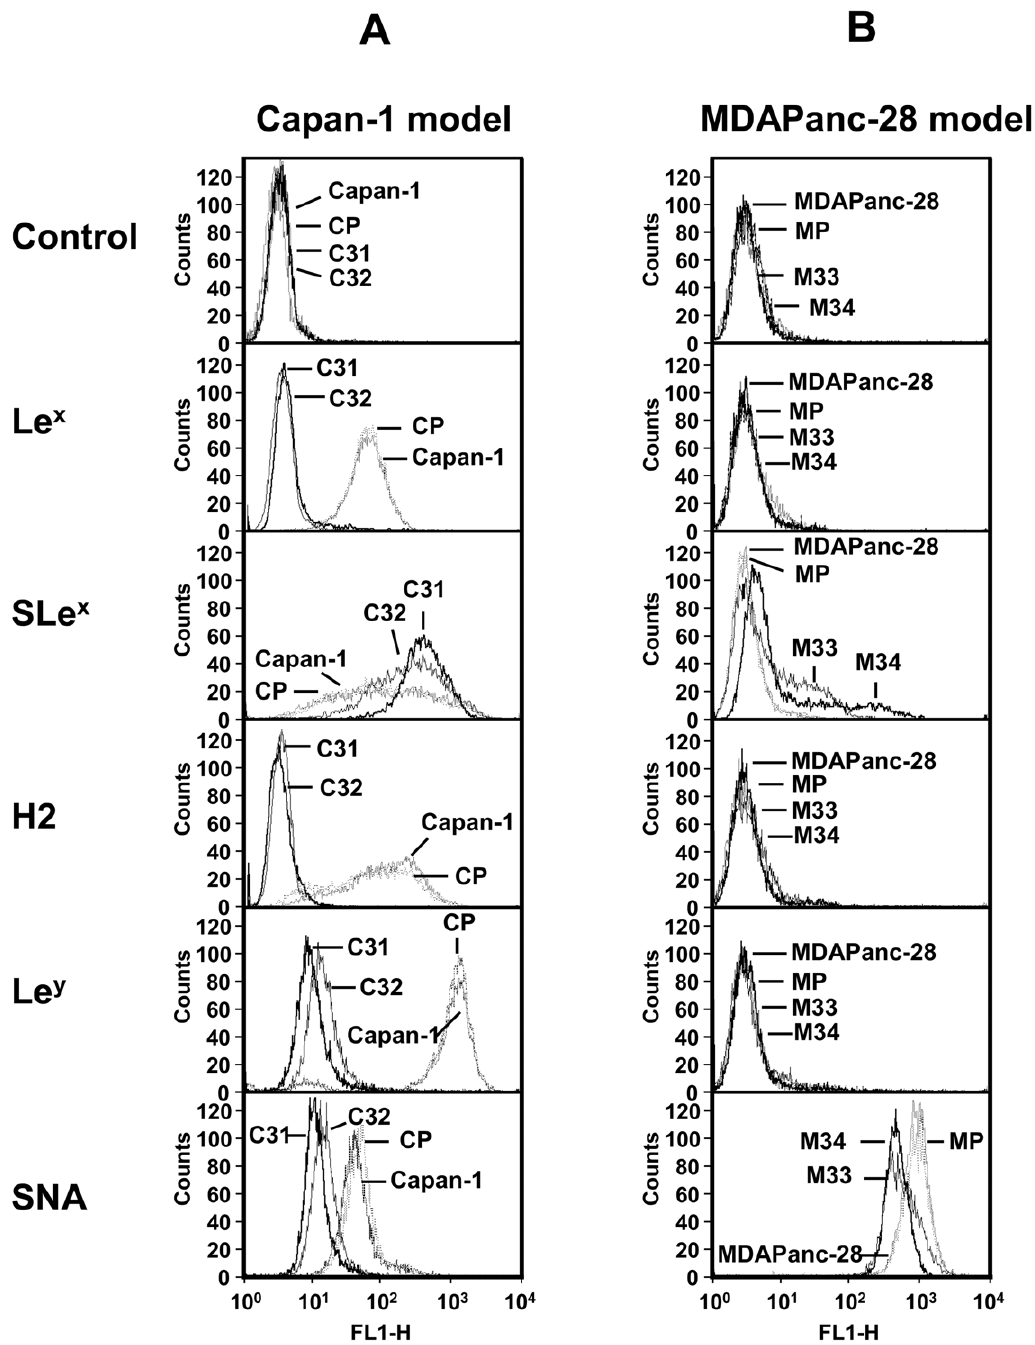
Figure 2. Flow cytometry profiles of the cell surface glycan structures of the pancreatic adenocarcionoma cells. Figure 2A . Capan-1 (continous dot outline: ………), CP (spaced dot outline: . . . . . ), C31 (bold outline:_______), C32 (plain outline:______). Figure 2B . MDAPanc-28 (continous dot outline: ………), MP (spaced dot outline: . . . . . ), M34 (bold outline:_______), M33 (plain outline:______). Experiments were performed for triplicate. Representative cytometry histograms are shown. Anti-Le x MAb binds to Gal b 1,4[Fuc a 1,3]GlcNAc-; anti-SLe x MAb binds to NeuAc a 2- 3Gal b 1,4[Fuc a 1,3]GlcNAc-; anti-H2 MAb binds to [Fuc a 1,2]Gal b 1,4GlcNAc-; anti-Le y MAb binds to [Fuc a 1,2]Gal b 1,4[Fuc a 1,3]GlcNAc-; SNA lectin ( Sambucus nigra agglutinin) binds to NeuAc a 2–6Gal b - structures. doi:10.1371/journal.pone.0012524.g002 H2 and Le y ). Moreover, accompanying the increase in SLe x , a antigens SLe a , Le a , Le b and H1 were not detected in the Capan-1 decrease in a 2,6-sialic acid was observed, detected by Sambucus model (data not shown). Thus, these results evidenced a multiple nigra agglutinin (SNA). Maackia amurensis agglutinin (MAA) did not enzymatic competition for Type II chains. The analysis of show differences among clones, probably due to the fact that is MDAPanc-28 ( Figure 2B ) model showed that MDAPanc-28 unable to bind to SLe x structure (data not shown). Type I Lewis and MP control cells had very low SLe x expression and high a 2,6-